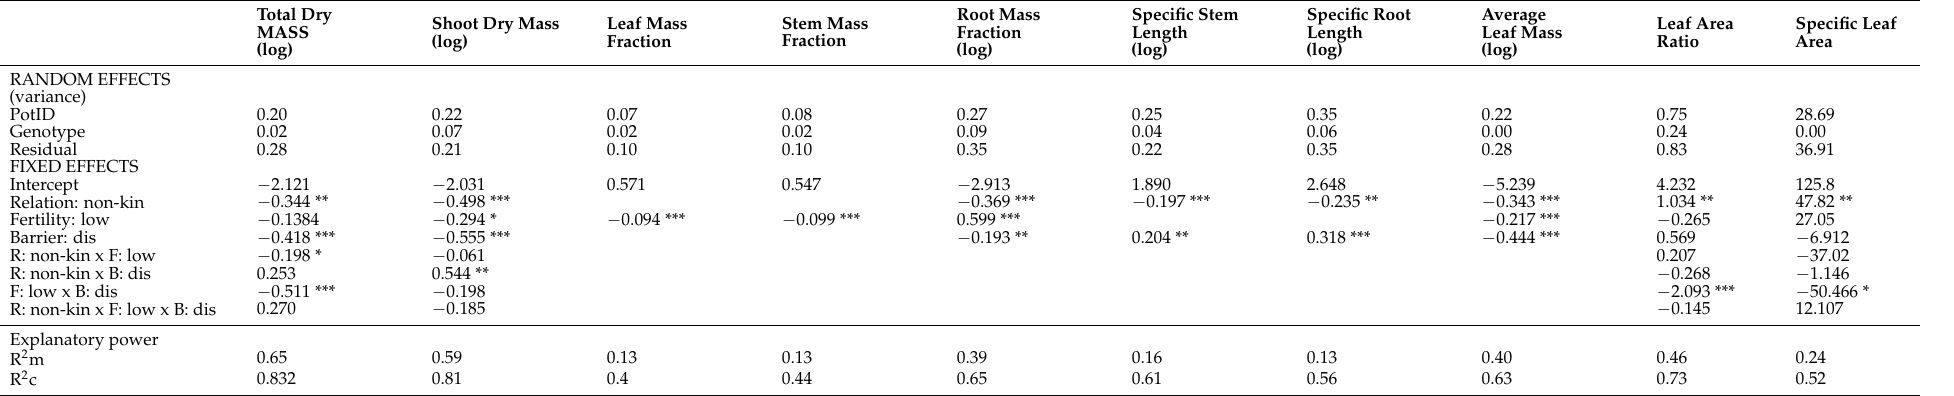
Table 1. Summarized statistical results showing best linear mixed models selected for each response variable based on AICc comparisons (delta AICc < 2) of all subset models of the fixed effects (random effects were retained in all subset models). (delta AICc < 2). Transformations applied to normalize response data prior to regression are indicated. Coefficient estimates are conditional averages across selected models. Random effect variances and R 2 estimates are taken from the maximum interaction model (R 2 m = marginal R 2 value, shows the variance explained by fixed effects; R 2 c—condition R 2 value, shows the variance explained by fixed plus random effects). “R”, “F”, and “B” represent relation, fertility, and barrier, respectively. Coefficient significance is indicated (* p < 0.05; ** p < 0.01, *** p < 0.001).